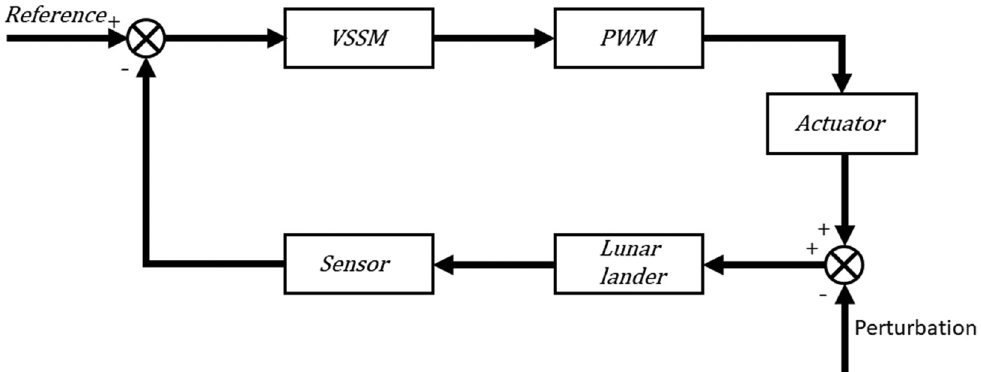
Figure 3: Soft landing control